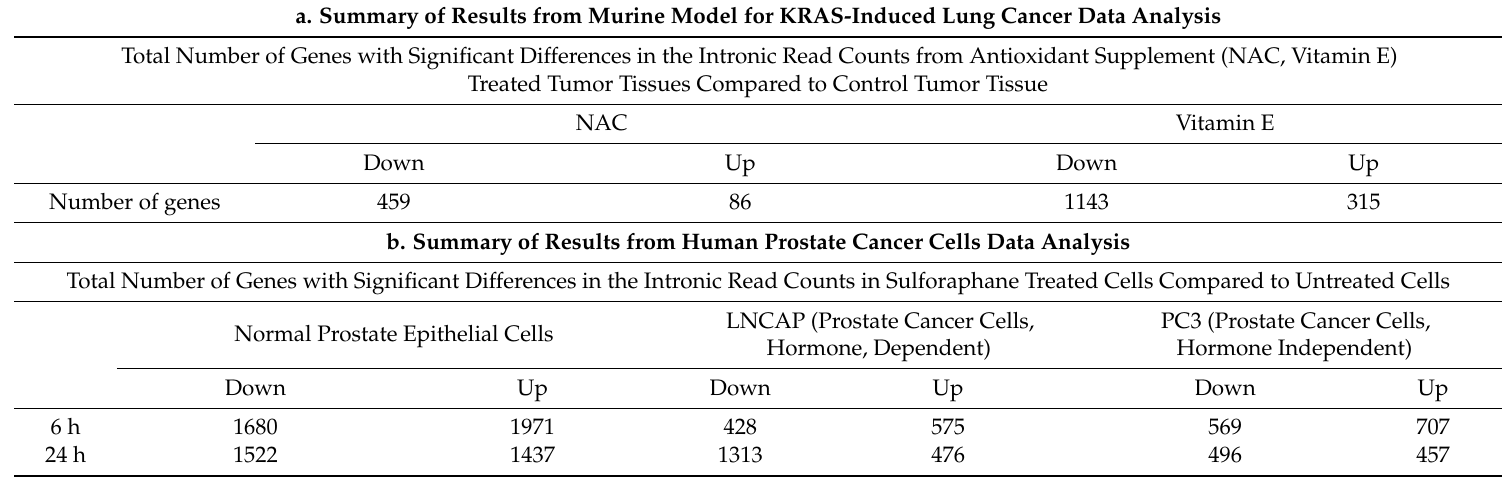
Table 2. Summary of the total number of genes with significant differential expression of introns (FDR < 0.01 and fold change >2 (up or down)). a. Summary of Results from Murine Model for KRAS-Induced Lung Cancer Data Analysis